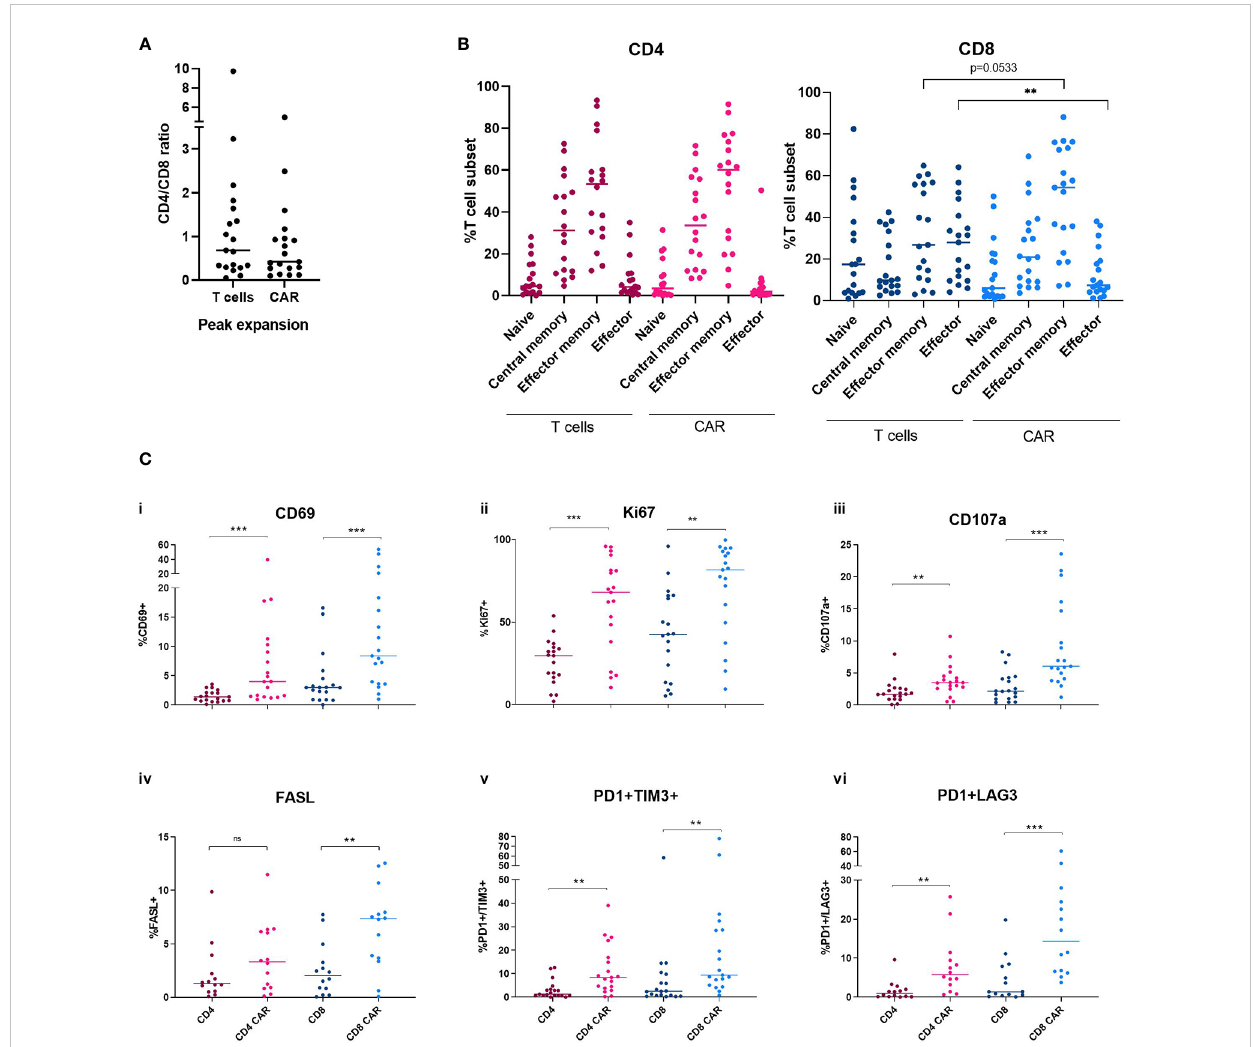
FIGURE 3 Immunophenotype characterization of non-modi fi ed T cells and CAR-T cells at the time of peak expansion in blood. (A) CD4/CD8 ratio of non- modi fi ed T cells and CAR-T cells at the time of peak expansion. (B) Memory subsets of CD4+ and CD8+ compartments comparing non-modi fi ed and CAR-T cells. (C) Levels of CD69 (i), Ki67 (ii), CD107a (iii), FasL (iv), PD1 and TIM3 (v) and PD1 and LAG3 (vi) in the CD4 and CD8 non-modi fi ed and CAR-T cells at the time of peak expansion. Depicted are median and individual values of the nine-teen samples. P-values between the indicated groups were calculated using unpaired Mann-Whitney U-t tests. ns: non-signi fi cant, **p<0.01,